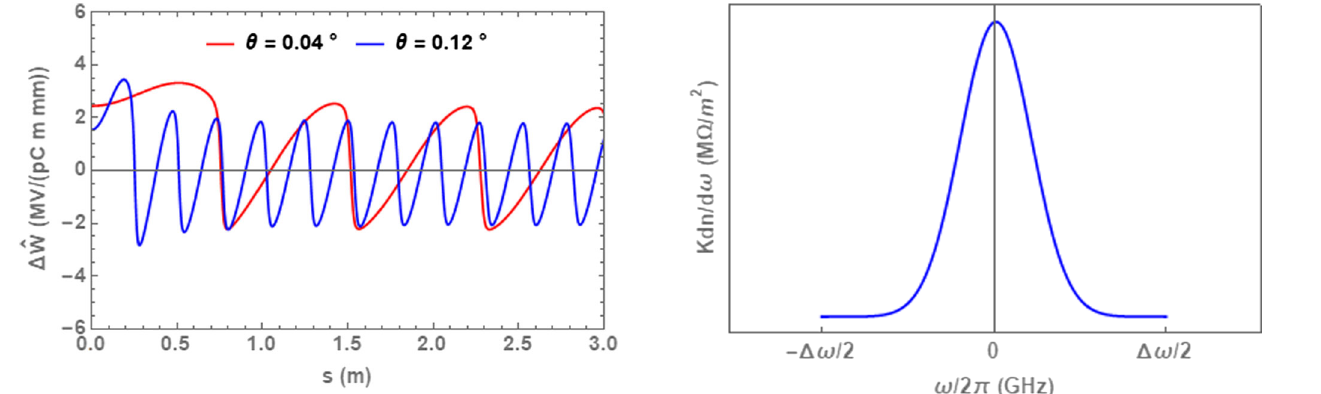
FIG. 26. The profile of the quantity K d n= d ω for a Gaussian tapered structure which is to be Fourier transformed to find the